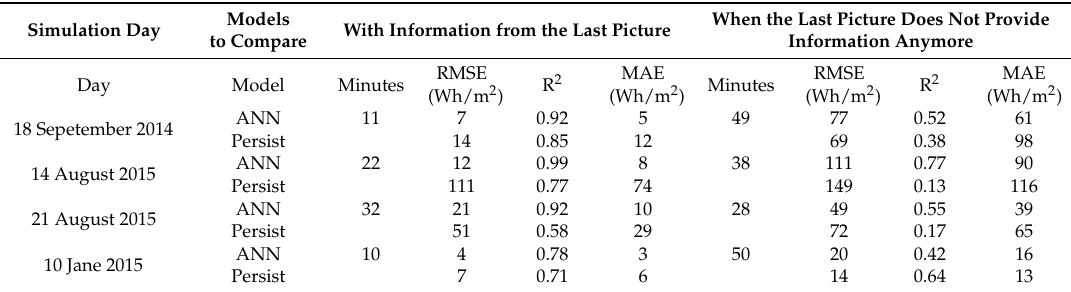
Table 3. Comparison of the statistical indicators of the new ANN forecast model against the persistence forecast model on four different days. The table compares the information until the last picture with the information after the last picture.